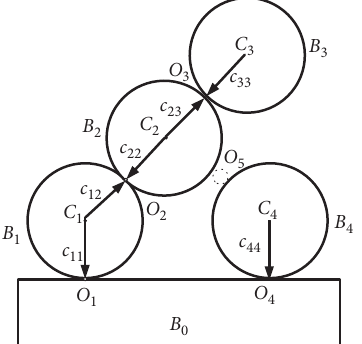
Figure 4: Relationship of the main frame based on relative co- ordinates theory.